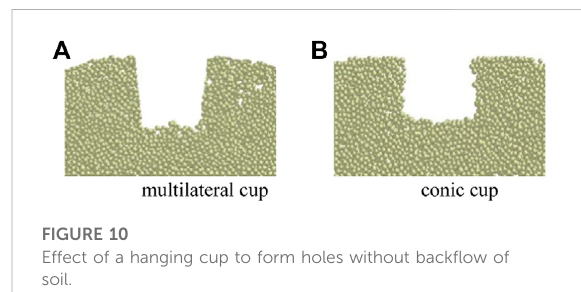
FIGURE 10 Effect of a hanging cup to form holes without back fl ow of